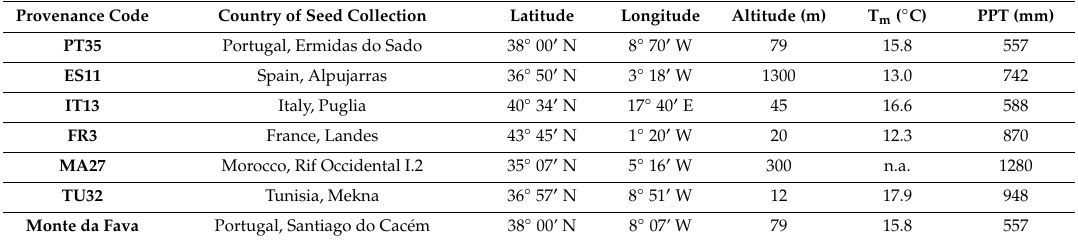
Table 4. Characterization of the trial site and identification of the Quercus suber provenances with collection site location, T m annual average air temperature ( ◦ C) and the long-term annual average precipitation (PPT, mm) (adapted from Varela [23]) and characterization of the provenance trial of Quercus suber (Herdade do Monte